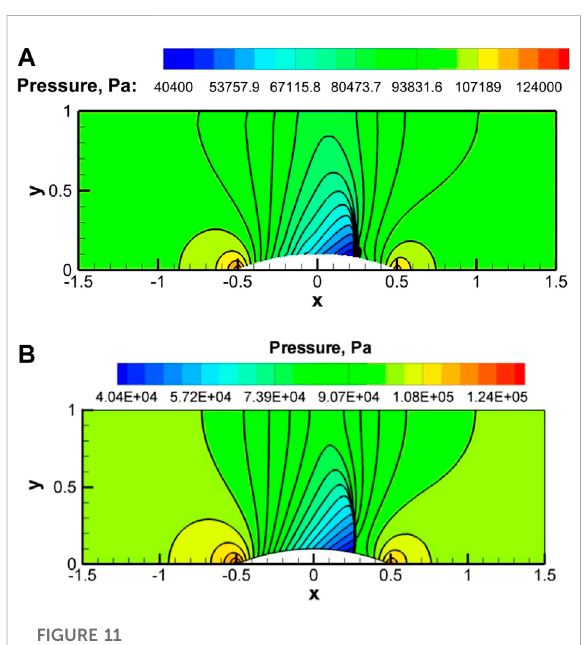
FIGURE 11 Pressure contours using the present IBM (A) and CUS-IBM (Kumar et al., 2020) (B) for the transonic fl ow over a